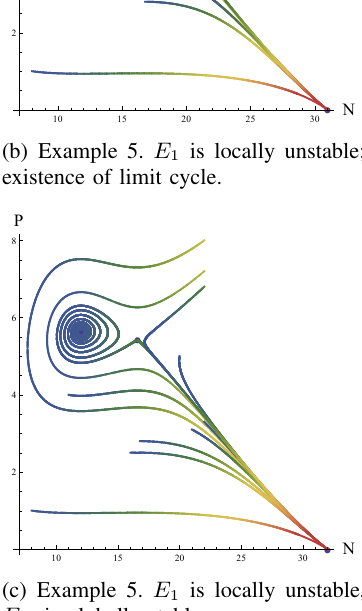
Fig. 10. Dynamics of the system (4) in the case of two internal equilibrium points E 1 and E 2